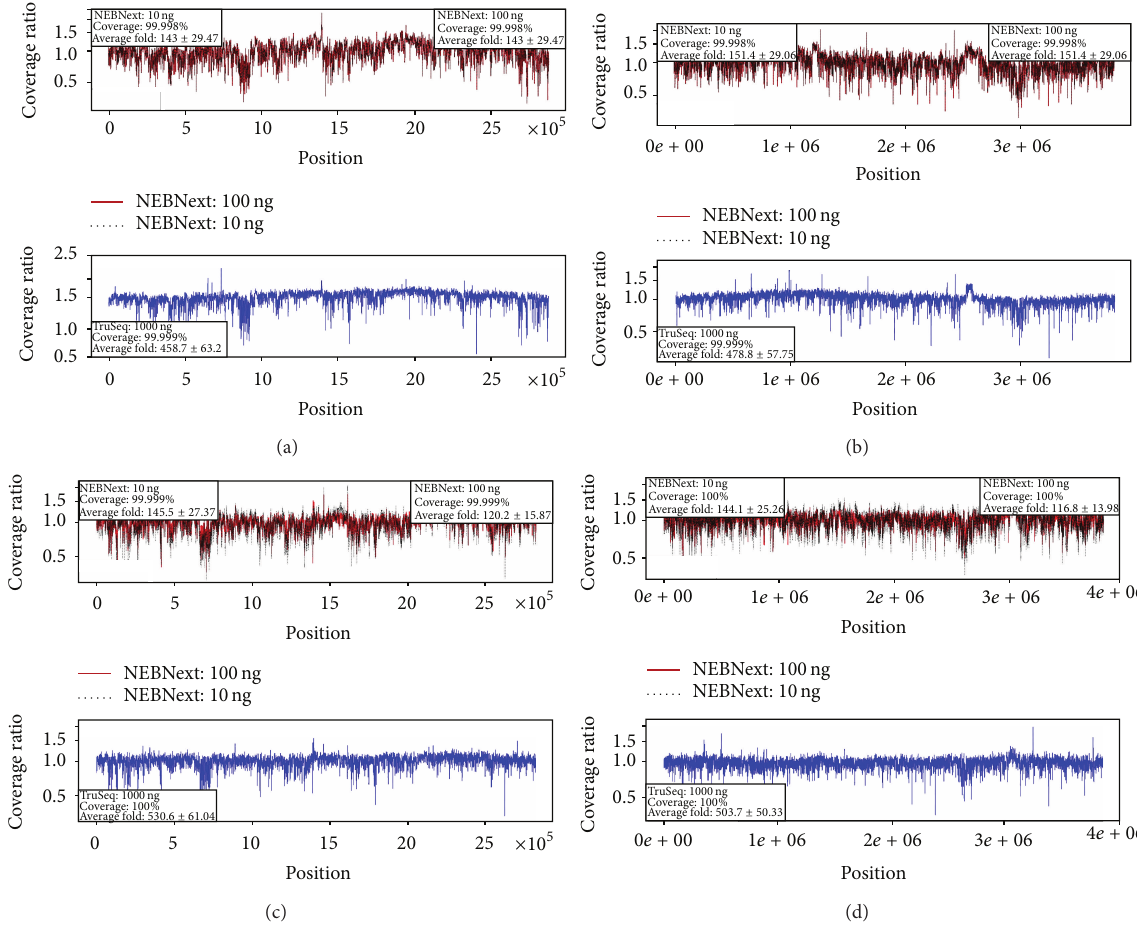
Figure 2: Evenness of coverage plots for B. thailandensis A ((a) is chromosome 1 and (b) is chromosome 2) and B. thailandensis B ((c) is chromosome 1 and (d) is chromosome 2) genome sequencing. Top graph within each panel shows NEBNext library preparation data with 10ng or 100ng DNA input (black color is for 10ng samples and red color is for 100 ng samples). Bottom graph within each panel shows TruSeq library preparation data with 1,000 ng DNA input. Plots are normalized by the average coverage in each figure.